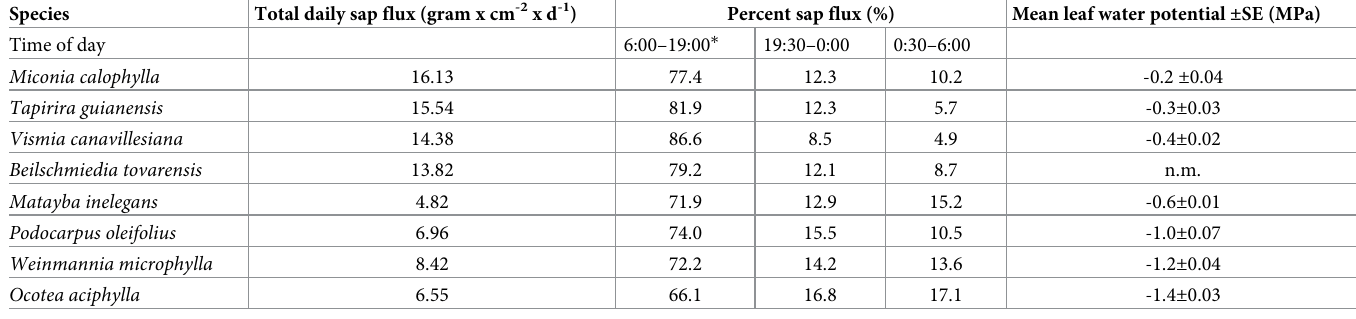
Table 2. Distribution of the diurnal sap flux in eight evergreen tree species over day and night and average water potential of the leaves. n.m. = not measured. ± indi- cates standard errors. Species Total daily sap flux (gram x cm -2 x d -1